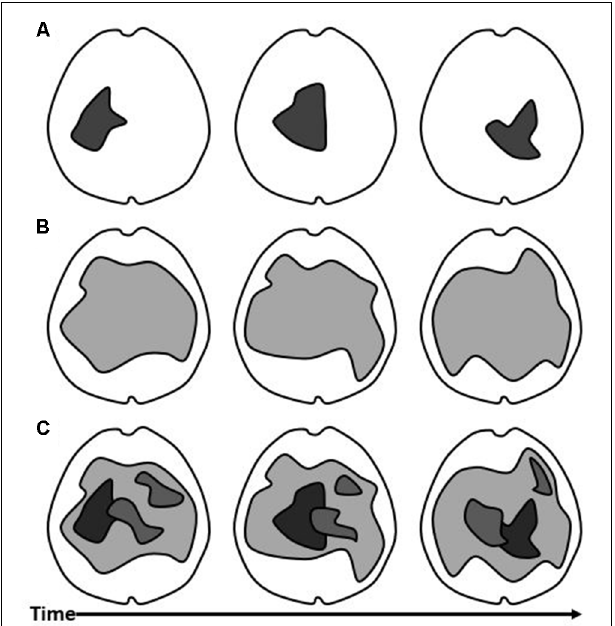
FIGURE 2 | Models of Consciousness. The thalamocortical substrate of consciousness, proposed by different theories can be generally mapped onto these models . TIC is represented as the darkness of the color gray. (A) In this model, the substrate of consciousness is a single, highly integrated network in the thalamocortical system. Over time, its spatial character and position in the brain changes (different shapes at different positions in the three panels). (B) In this model, the substrate of consciousness is a single, large, and integrated or resonant network in the thalamocortical system. Its elemental make-up changes over time (gray shape over three panels). (C) In this third model, the substrate of consciousness consists of a large, integrated network in the thalamocortical system (light gray), which can undergo some elemental change across time (shape across panels). Nested within this network are smaller networks with higher TIC (darker